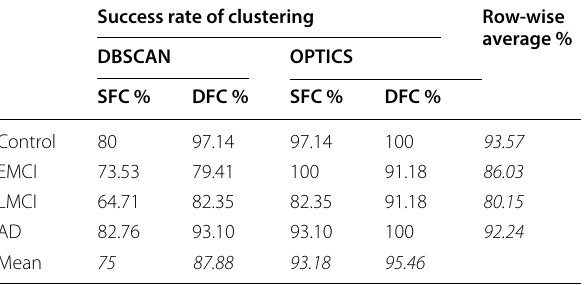
Row-wise averages (last column) and column-wise averages (last row), shown in italics, provide summary statistics Table 3 SNR values obtained as a measure of robustness